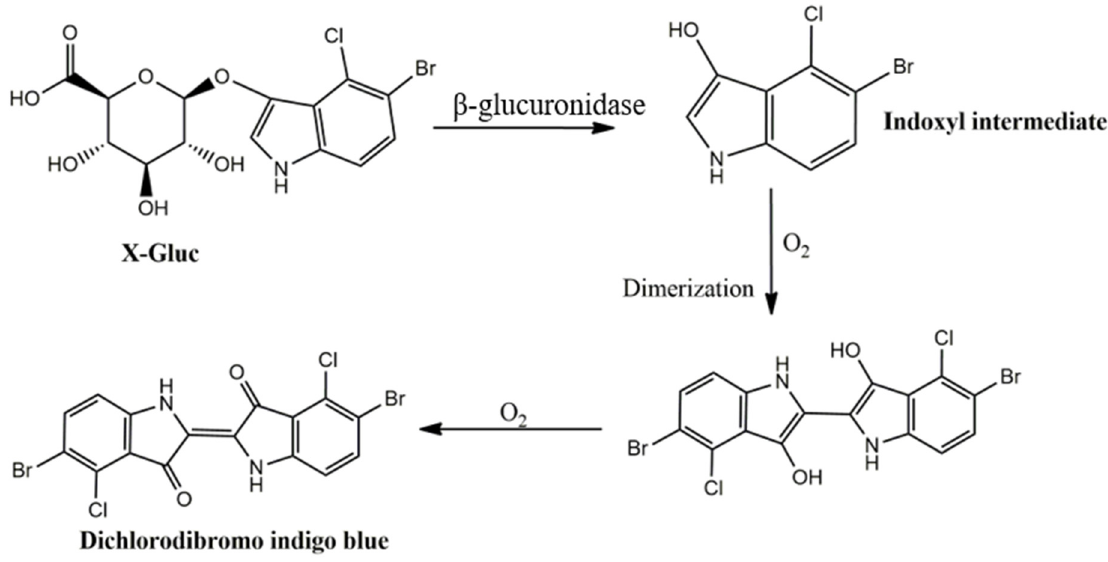
Figure 2 . Dimerization of the indoxyl derivative from hydrolysis of X-Gluc to yield the blue indigo reporter dye derivative.